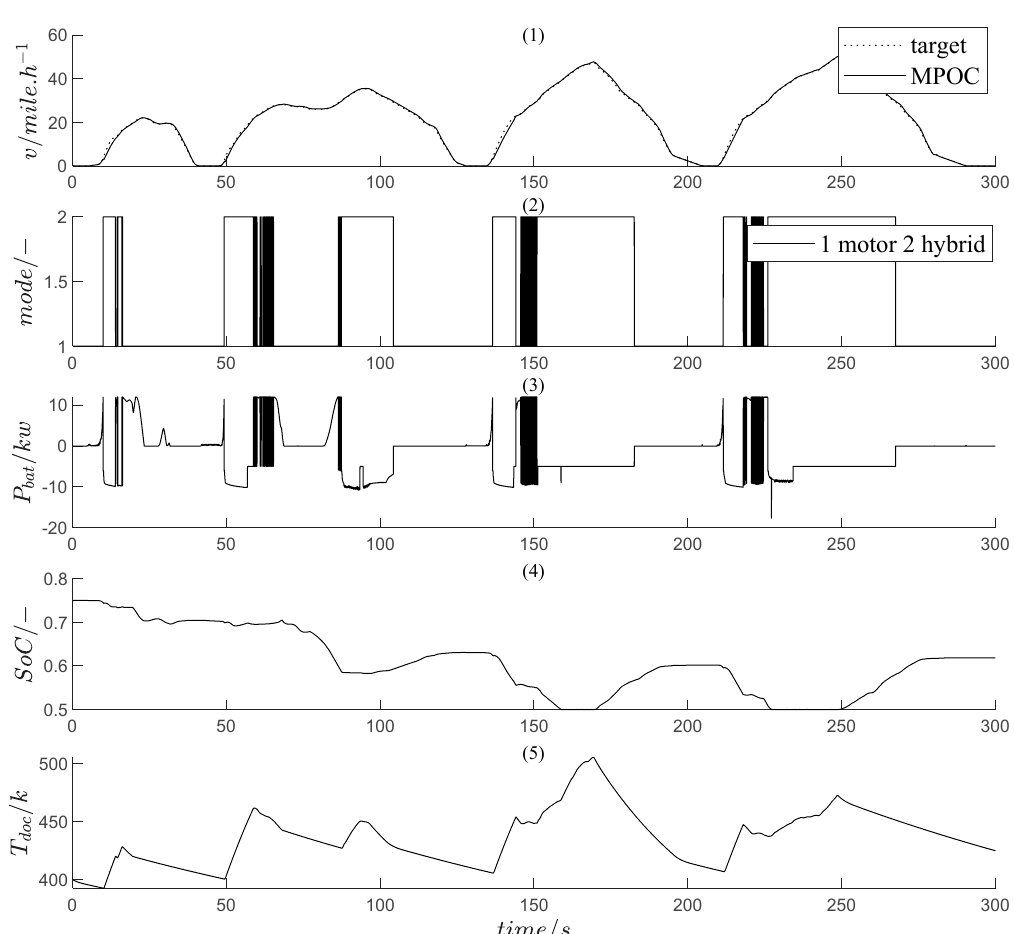
Figure 10. Working process of the diesel hybrid electric system under the MPOC method: ( 1 ) the speed target of the cycle and the tracking states of the controller, ( 2 ) the switching process of energy mode rule (EM rule), 1 represents the motor mode, 2 represents the engine mode, ( 3 ) P bat , ( 4 ) SoC , ( 5 ) T doc